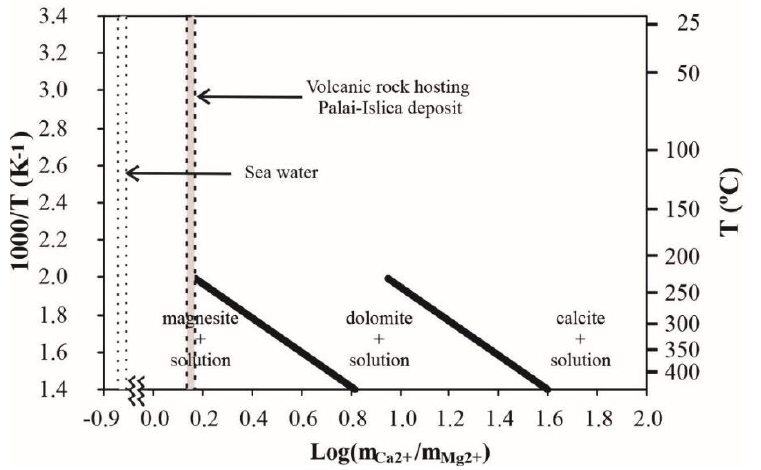
Figure 11. Binary diagram showing the stability fields of calcite, dolomite, and magnesite as the Ca/Mg activity ratio and temperature function. The stability limits were calculated from replacing conditions of one phase by others (adapted from [43]). For reference, marine water [44] and the Ca/Mg ratio of unaltered andesites/dacites hosting Palai-Islica deposit [45] are also shown.